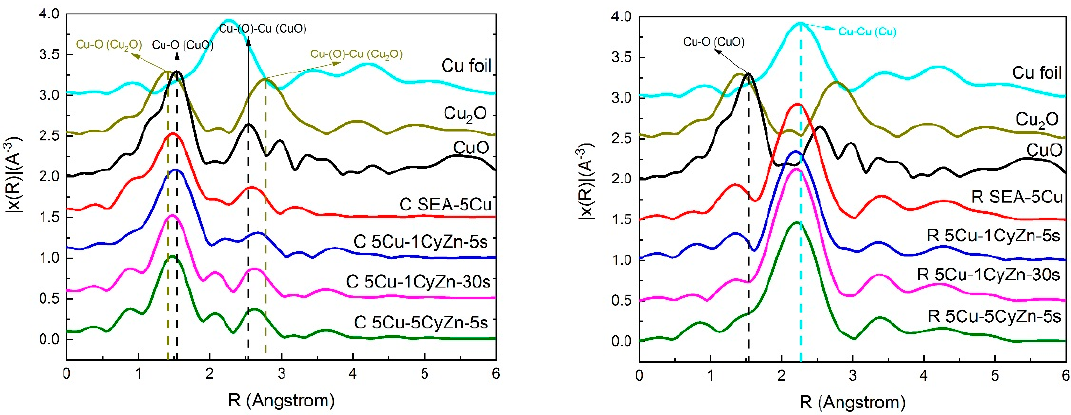
Figure 9. Experimental EXAFS spectra registered Cu K-edge of calcined ( left ) and reduced ( right ) SEA-5Cu and ZnO over-coated Cu/SiO 2 catalysts.